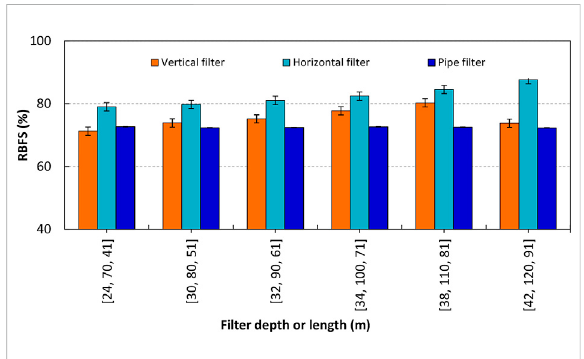
FIGURE 10 Riverbank fi ltration ef fi ciency for fi lter depth and length.